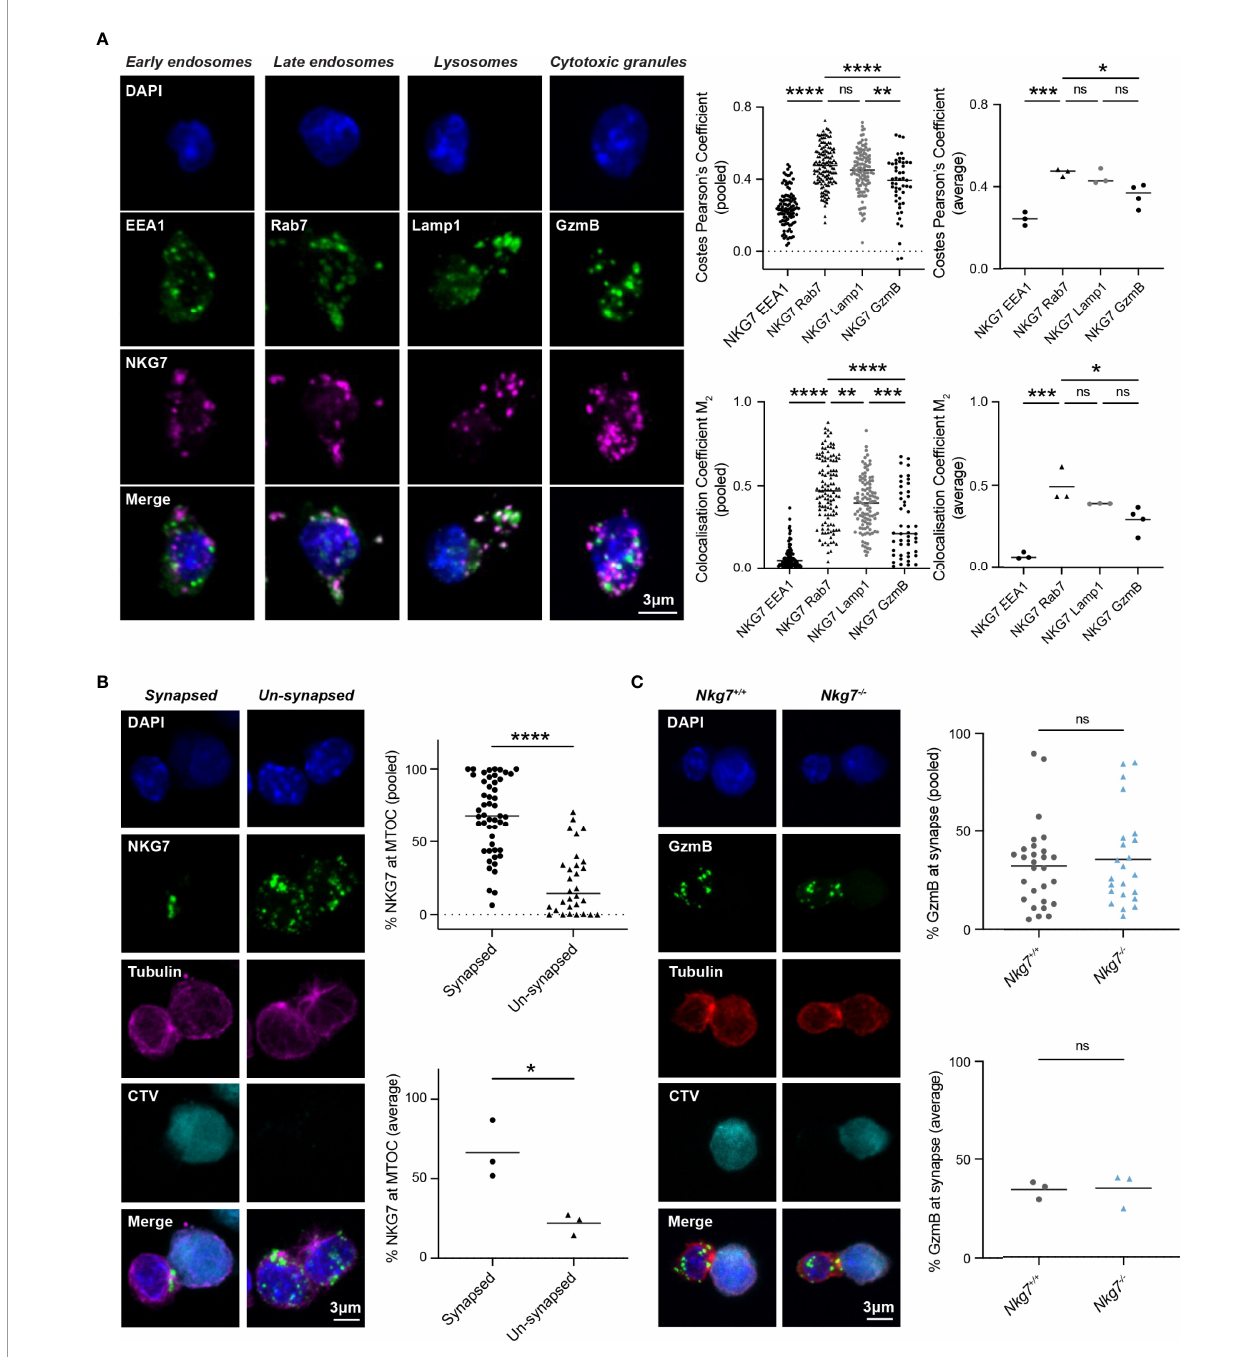
FIGURE 3 | NKG7 protein is localized to late endosomes and polarizes to the immune synapse upon target recognition. (A) Confocal immuno fl uorescence microscopy of Nkg7 +/+ CD8+ T cells showing co-localization of NKG7 (magenta) with Lamp-1 and Rab-7 (green; middle panels), but not EEA1 or GzmB (green; far left and right panels). Both Costes Pearson ’ s Correlation Coef fi cient and Manders Correlation Coef fi cient, were used to quantify co-localization (left); biological replicates (right). Comparisons made by one-way ANOVA, each dot represents an individual cell analyzed (n = 47-133) pooled from 3 independent experiments (average shown on right) (B) The percentage of NKG7 (green) present at the MTOC (magenta) for synapsed and un-synapsed Nkg7 +/+ CD8+ T cells, with synapse determined by polarisation of the MTOC to the interface of the two cells. Anti-CD3/28-coated P815 target cells were labelled with cell trace violet (CTV) and co- cultured with Nkg7 +/+ CD8+ T cells for 45 mins. Comparisons made by unpaired t test. Each dot represents an individual cell conjugate analyzed (n = 30-51) pooled from 3 independent experiments (average shown below) (C) The percentage of granzyme B (GzmB; green) present at the immune synapse (MTOC; red) in Nkg7 +/+ and Nkg7 -/- CD8+ T cells, during co-culture with target cells as described in (B) , unpaired t test. Each dot represents an individual cell conjugate analyzed (n = 23- 28) pooled from 3 independent experiments (average shown below) * P < 0.05, ** P < 0.01, *** P < 0.001, **** P < 0.0001. NS, not signi fi